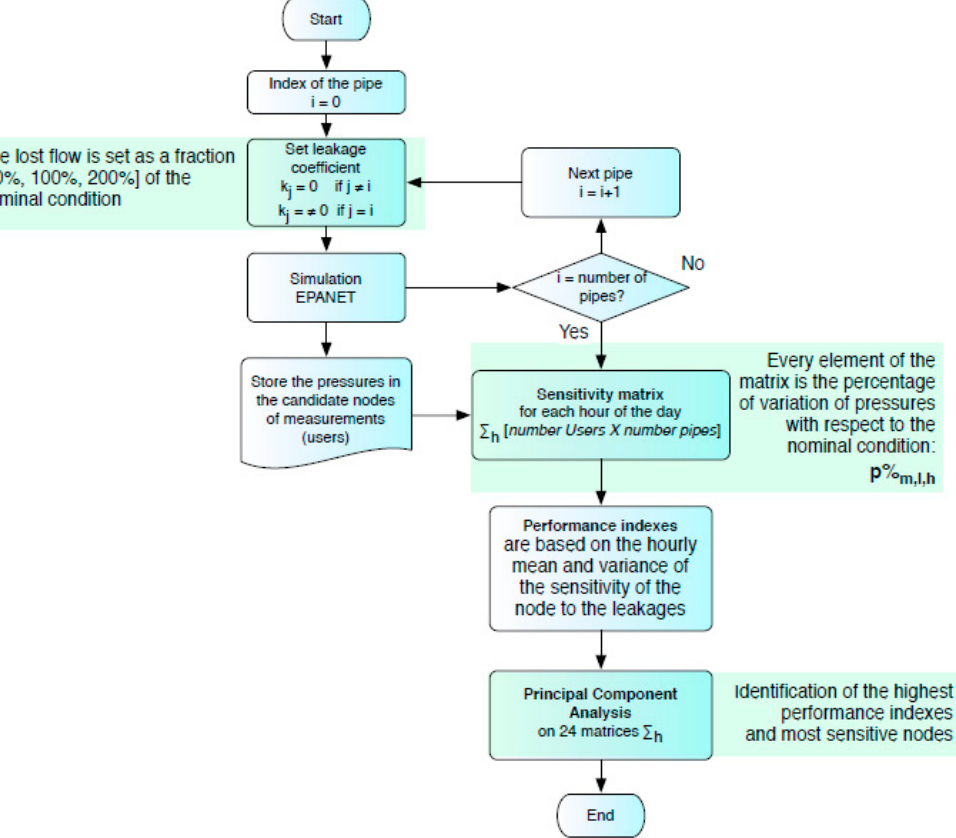
Figure 3. Algorithm scheme of the sensitivity analysis.